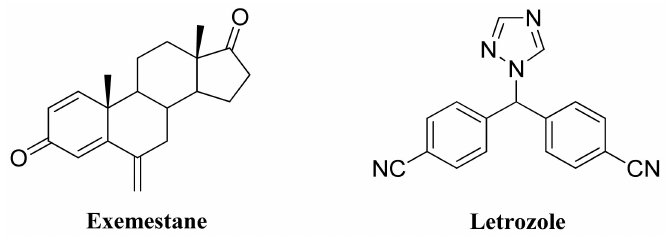
Figure 1. Chemical structures of the most representative steroidal and non-steroidal